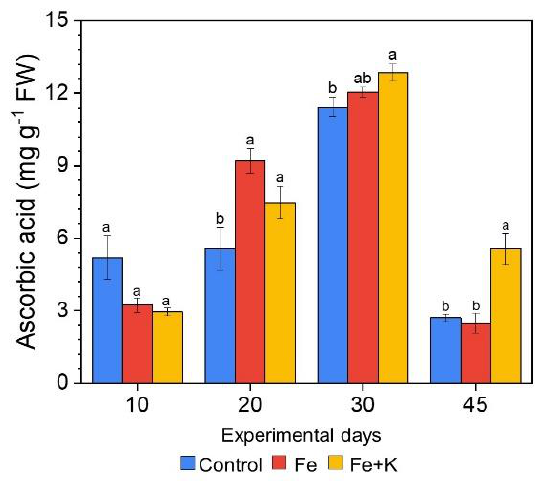
Figure 6. DPPH radical scavenging activity of lettuce leaves during the experimental period, ex- pressed as ascorbic acid equivalents (Mean ± SEM, n = 6). Different letters indicate significant differences among treatments at each experimental day ( p < 0.05).